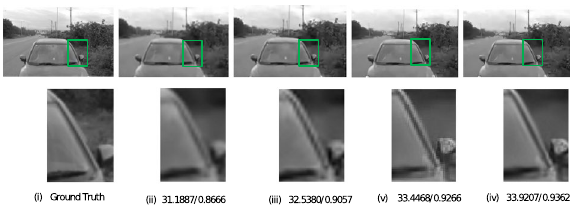
Figure 2. Result of enhancement on Car image with PSNR and SSIM values (i) Ground Truth (ii) Degraded low resolution Image (iii) Result of conventional IBP enhancement technique (iv) Result of Edge preserving IBP (v) Result of the proposed method.